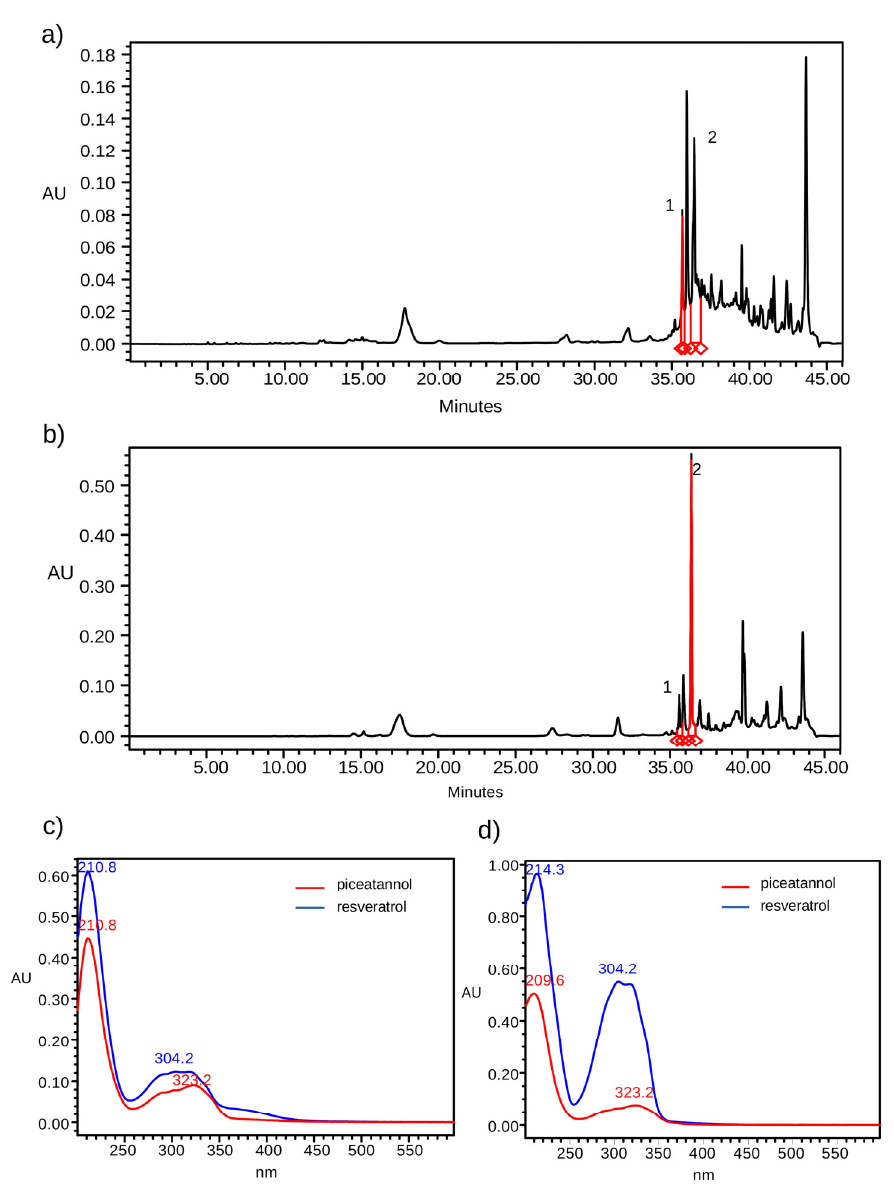
Figure 2. HPLC-DAD chromatograms (320 nm) of the extract obtained by the ultrasound method with ethanol ( a ) and with acetone ( b ). Number 1 and 2 corresponds to piceatannol and resveratrol, respectively. The UV spectra of piceatannol (red) and resveratrol (blue) detected on ethanol ( c ) and acetone ( d ) extracts.